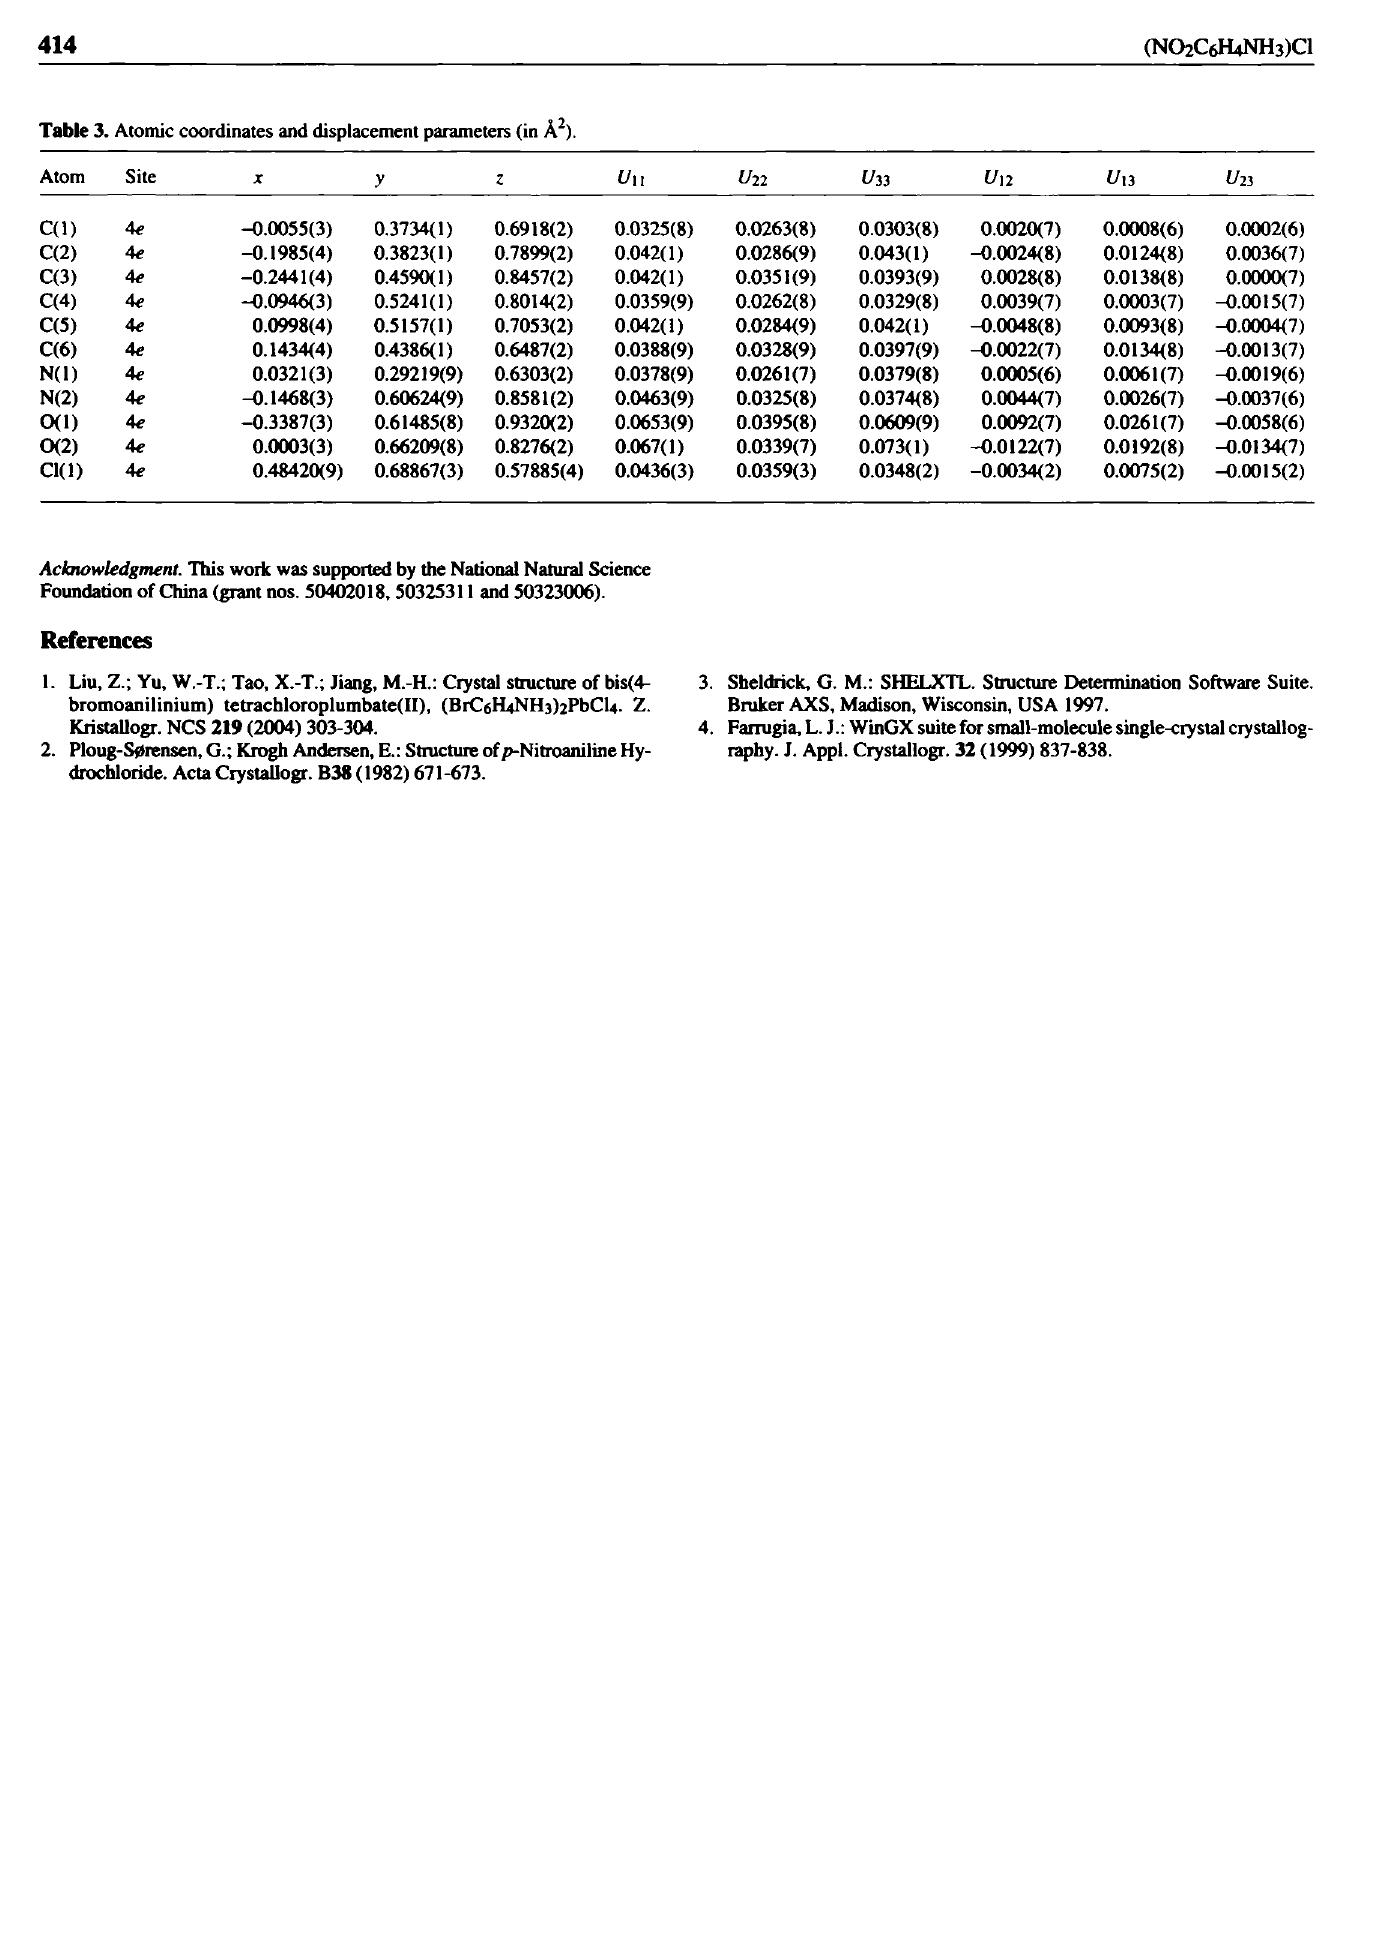
Table 3. Atomic coordinates and displacement parameters (in A 2